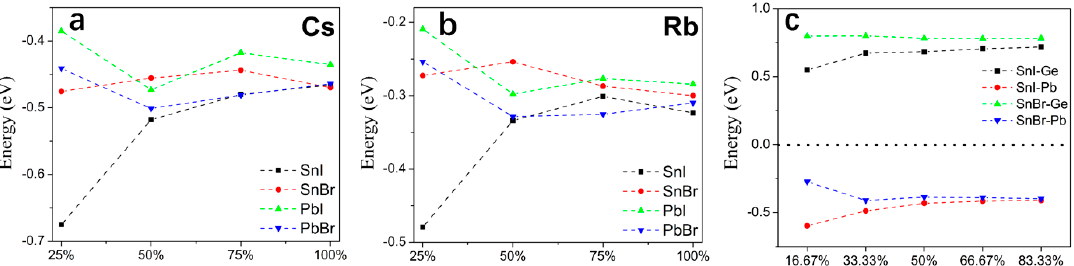
Figure 2. Formation energies of BA 2 MA 2 B 3 X 10 (B = Pb 2+ or Sn 2+ ; X = Br − or I − ) mixed with ( a ) Cs atom and ( b ) Rb atom. ( c ) Formation energy of BA 2 MA 2 Sn 3 I 10 mixed with the Ge or Pb atom.